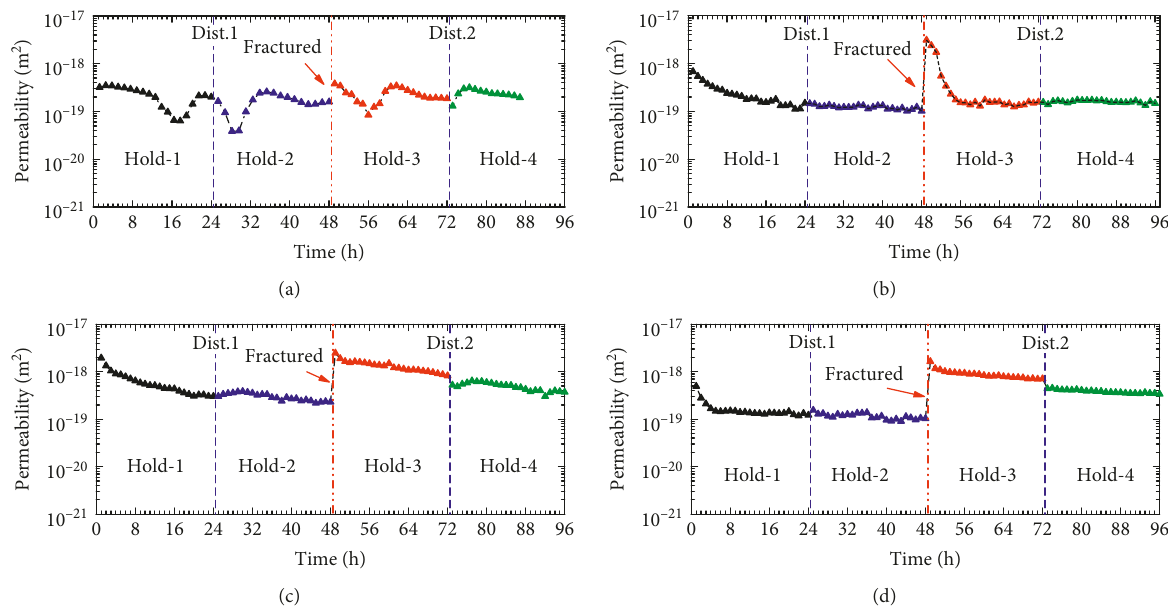
Figure 6: Variation in permeability in each hydrostatic stress state (Hold-1, Hold-2, Hold-3, and Hold-4) at the time of axial stress disturbance for the entire experiment: (a) AS-KCS2, (b) AS-KCS5, (c) AS-KCS8, and (d) AS-KCS9. Dist.1 and Dist. 2 are the disturbances in prefailure and postfailure.